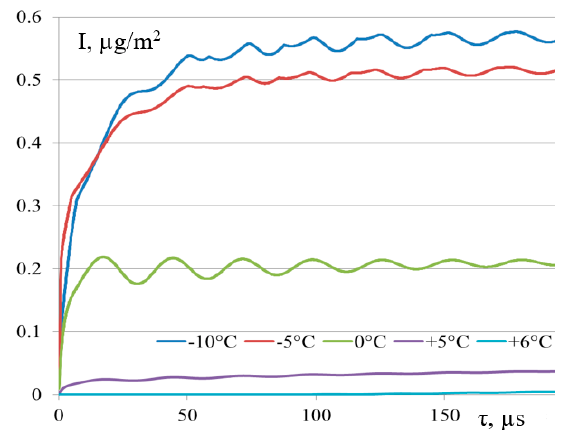
Figure 8. E ff ect of initial gas temperature deviation from thermodynamic equilibrium conditions on hydration formation processes (equilibrium values are shown in Table 1).